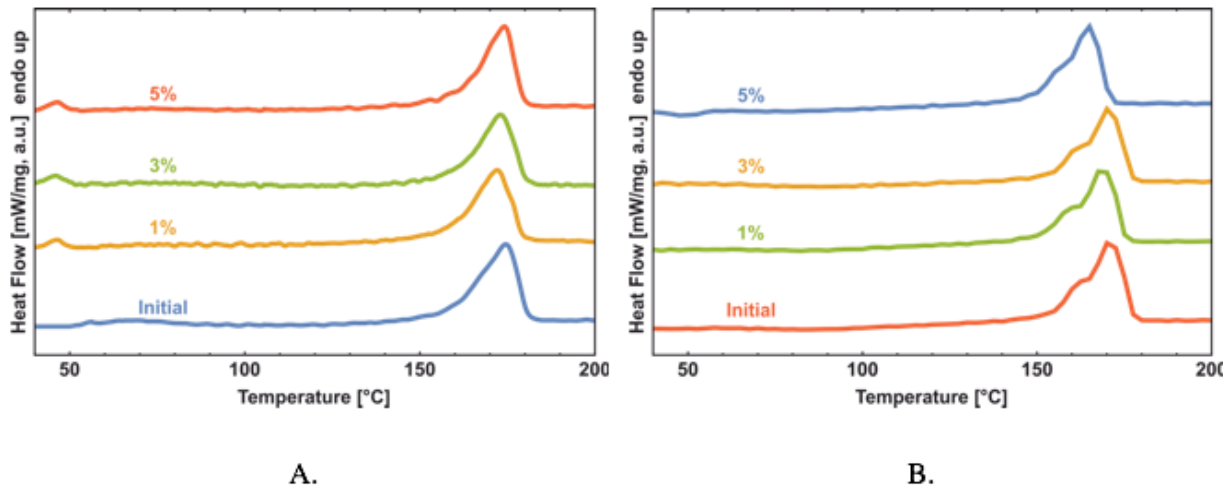
Figure 6. The DSC scans of Hmi/PHB with different content of Hmi: first heating run ( A ), second heating run ( B ).